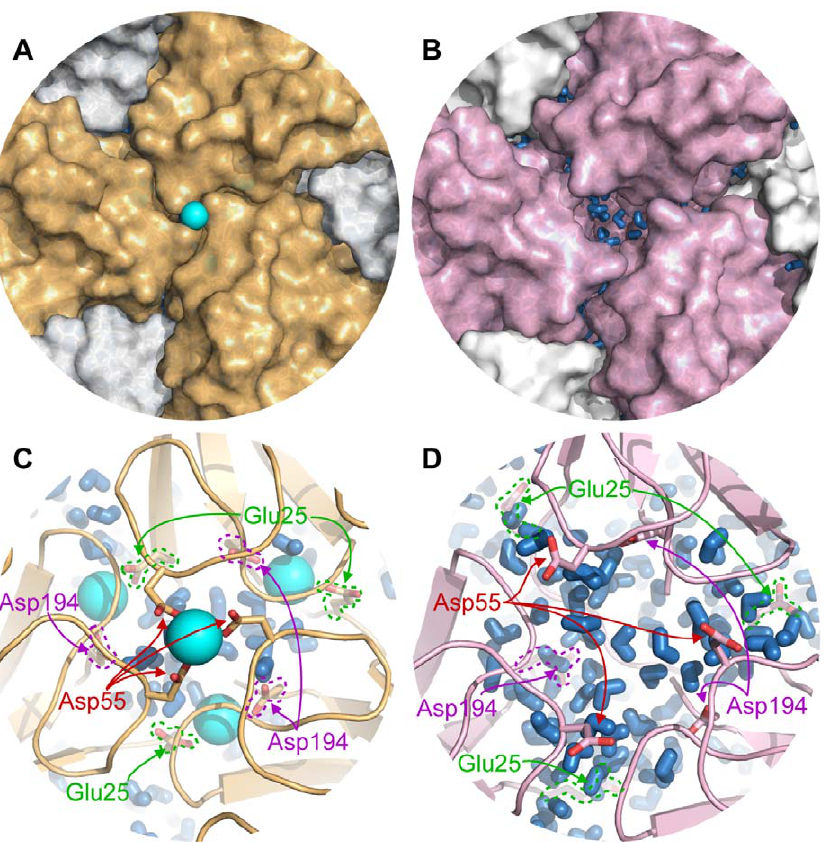
Figure 4. The 3-fold axis. Close-up of an icosahedral 3-fold symmetry axis from the final frame of the ( A, C ) Sim Ca D neut and the ( B, D ) Sim NoCa D neut trajectories showing the main water permeation site. Calcium ion depicted as a cyan sphere and water molecules as blue sticks.